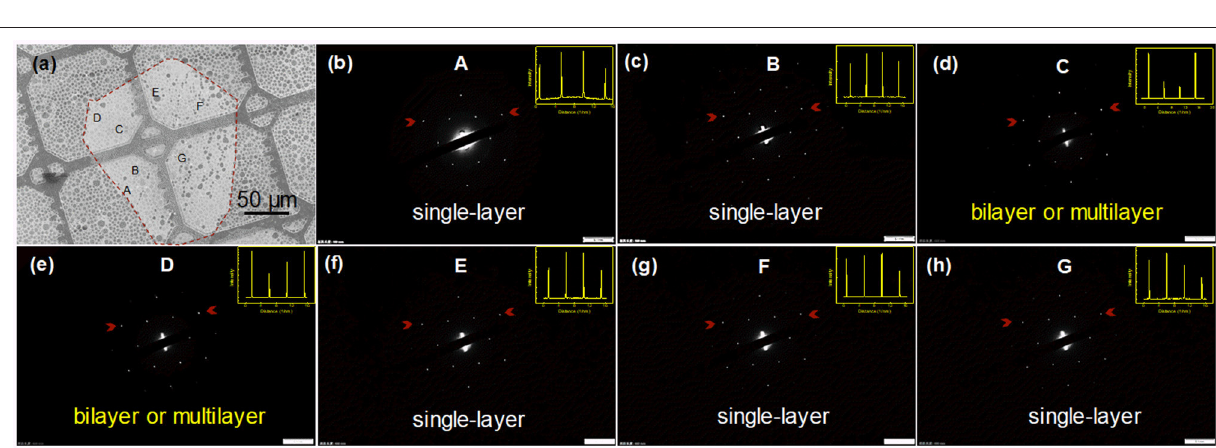
FIGURE 5 | TEM characterization of a graphene domain. (a) SEM image of a graphene domain suspending on a holey carbon supported grid. (b–h) SAED patterns collected from the labeled regions in (a) . Inset figures in the upper right are peak intensity profiles from the line marked by two red arrows in the SAED patterns, indicating the stacking style of